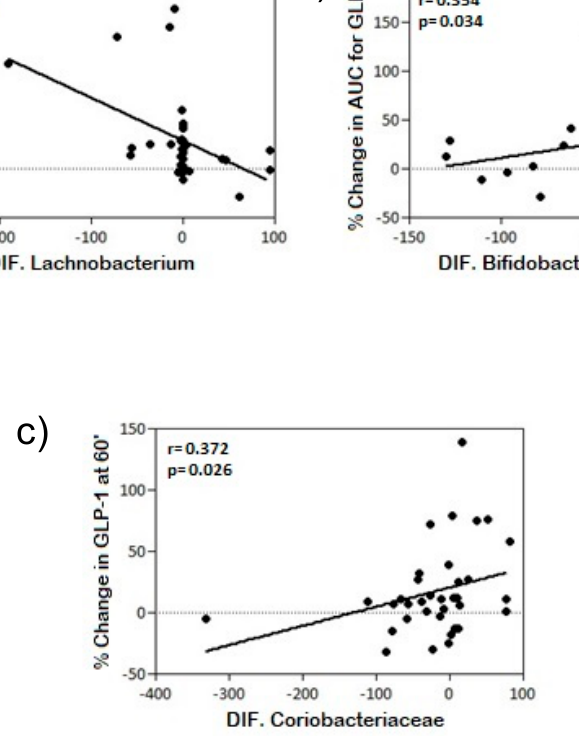
Figure 4. Correlation between changes in GLP-1 levels at minute 60 and the AUC for GLP-1 with percentage change in microbial community after antibiotic treatment: ( a ) with Lachnobacterium percentage change; ( b ) with Bifidobacterium adolescentis percentage change; and ( c ) with Coriobacteriaceae percentage